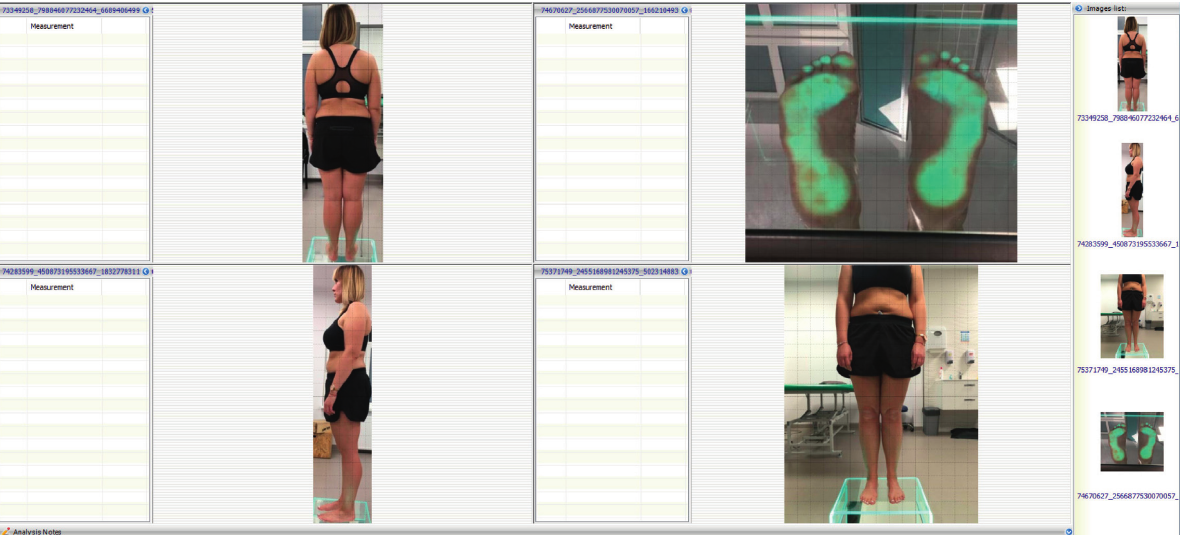
Figure 2: A photogrammetric examination performed using the BIOMECH Studio